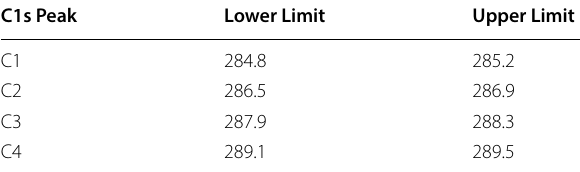
Table 1 Binding energy limits in the C1s energy